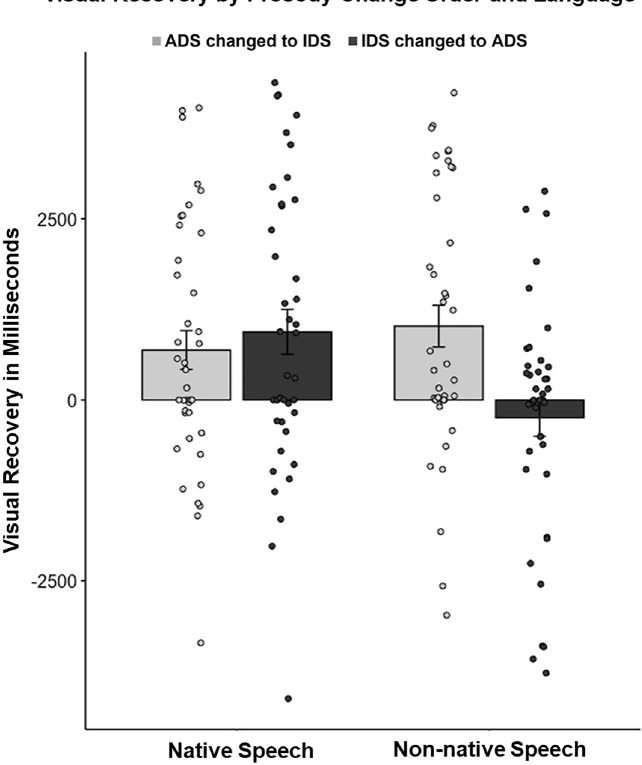
Figure 4. Plot of individual data of infant visual recovery in milliseconds after the prosody change, compared across language and order of prosody change. Bars represent average change scores by condition. Error bars represent standard error of the